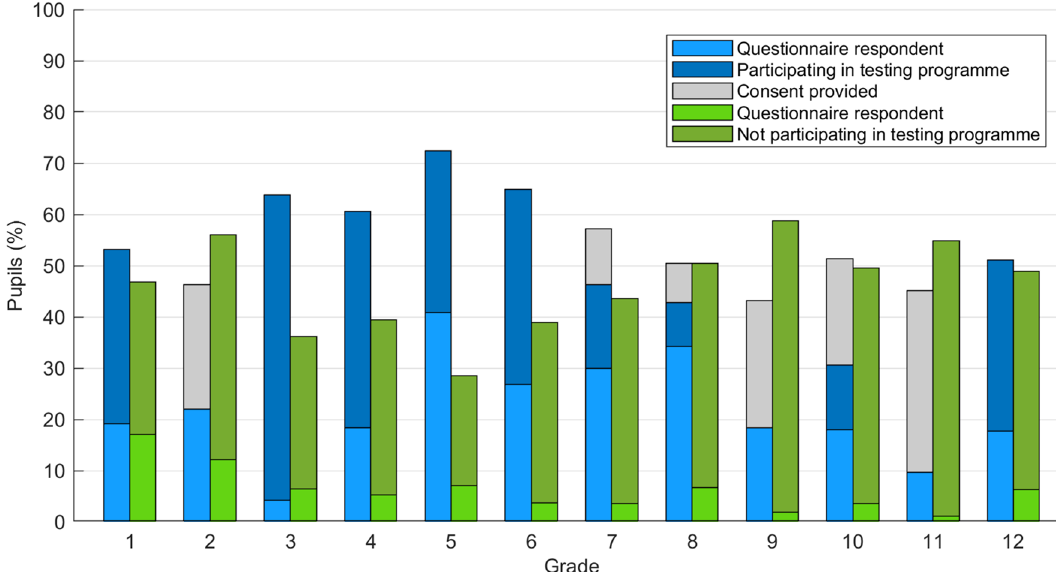
Figure 4. Positive response rates for participation in the testing programme and rates of responding to Questionnaire 3 (Q3) across the school grades, in which reasons for the decision over whether to participate in testing were investigated. The blue bars indicate participation in Q3 by parents and/or legal guardians providing consent to participation in the testing programme, and the green bars indicate participation in Q3 by parents and/or legal guardians not providing consent to participation in the testing programme. Gray indicates the pupils for whom consent was provided, but the minimum participation threshold was not reached for the class.